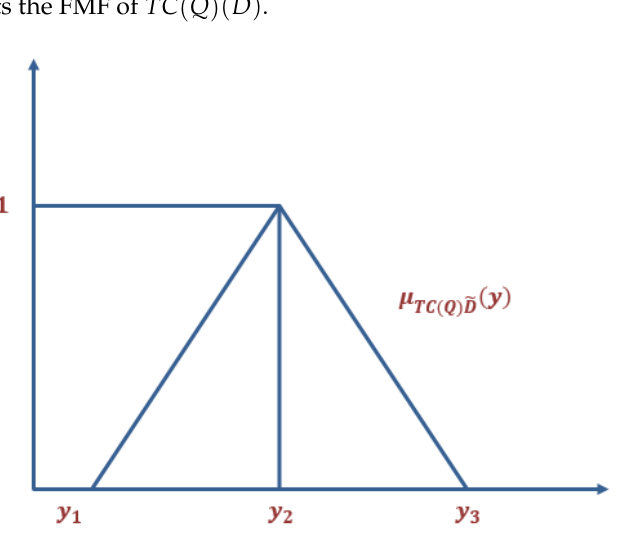
Figure 5. Triangular fuzzy number TC ( Q )( (cid:101) D )